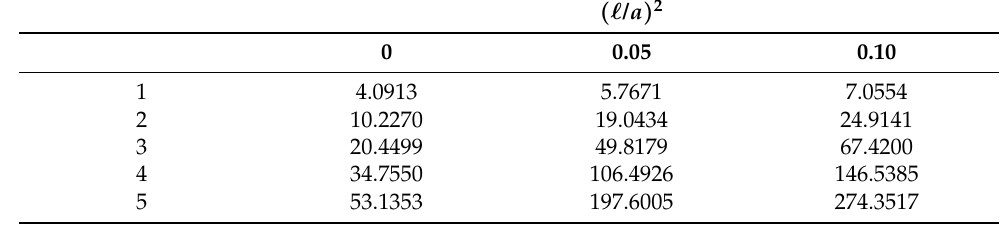
Table 5. Natural frequencies ¯ ω of a simply supported square FG nanoplate composed by BaTiO 3 /CoFe 2 O 4 .